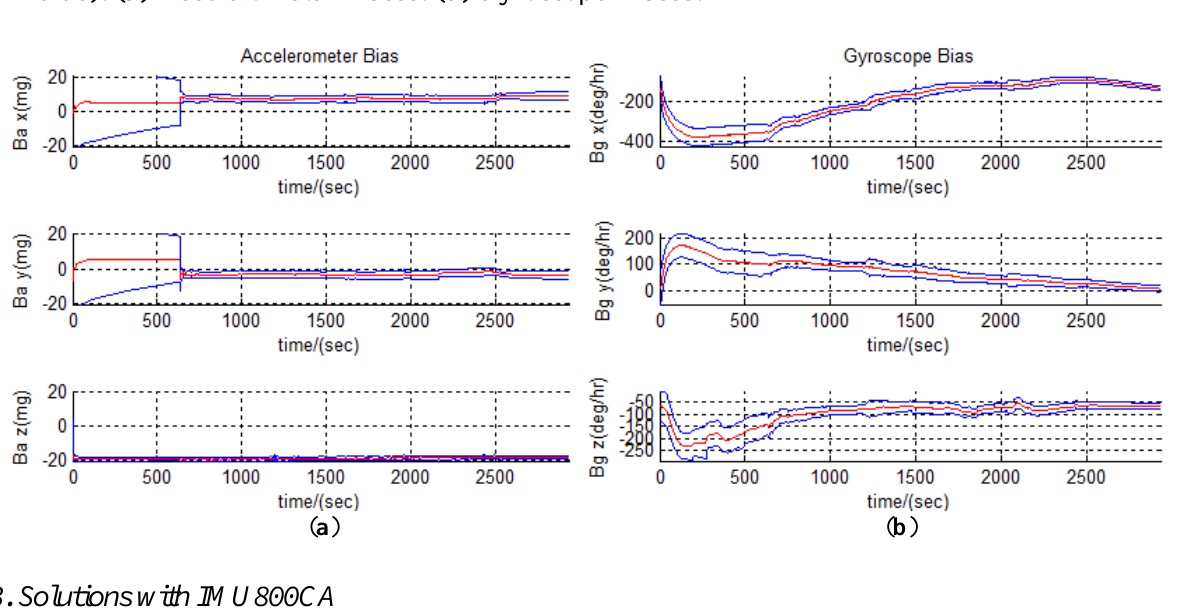
Figure 10. The estimated IMU biases with IMU440CA (3-sigma envelope accuracy in blue). ( a ) Accelerometer Biases. ( b ) Gyroscope Biases.